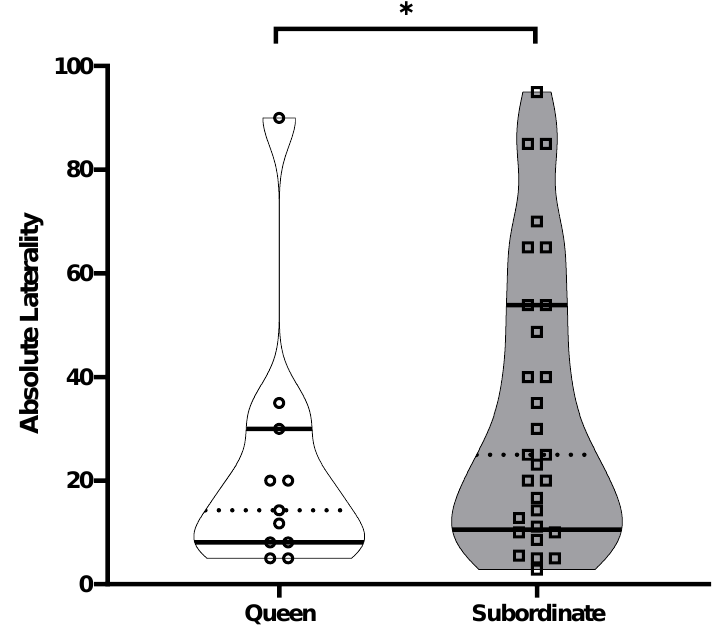
Figure 3. The absolute laterality (directional strength in laterality) in the Damaraland mole rat Fukomys damarensis between queens (open circles: n = 11) and non-reproductive subordinates (open squares: n = 29). The dashed line represents the median, with solid lines representing the upper and lower quartiles. * indicates significance at p < 0.05.